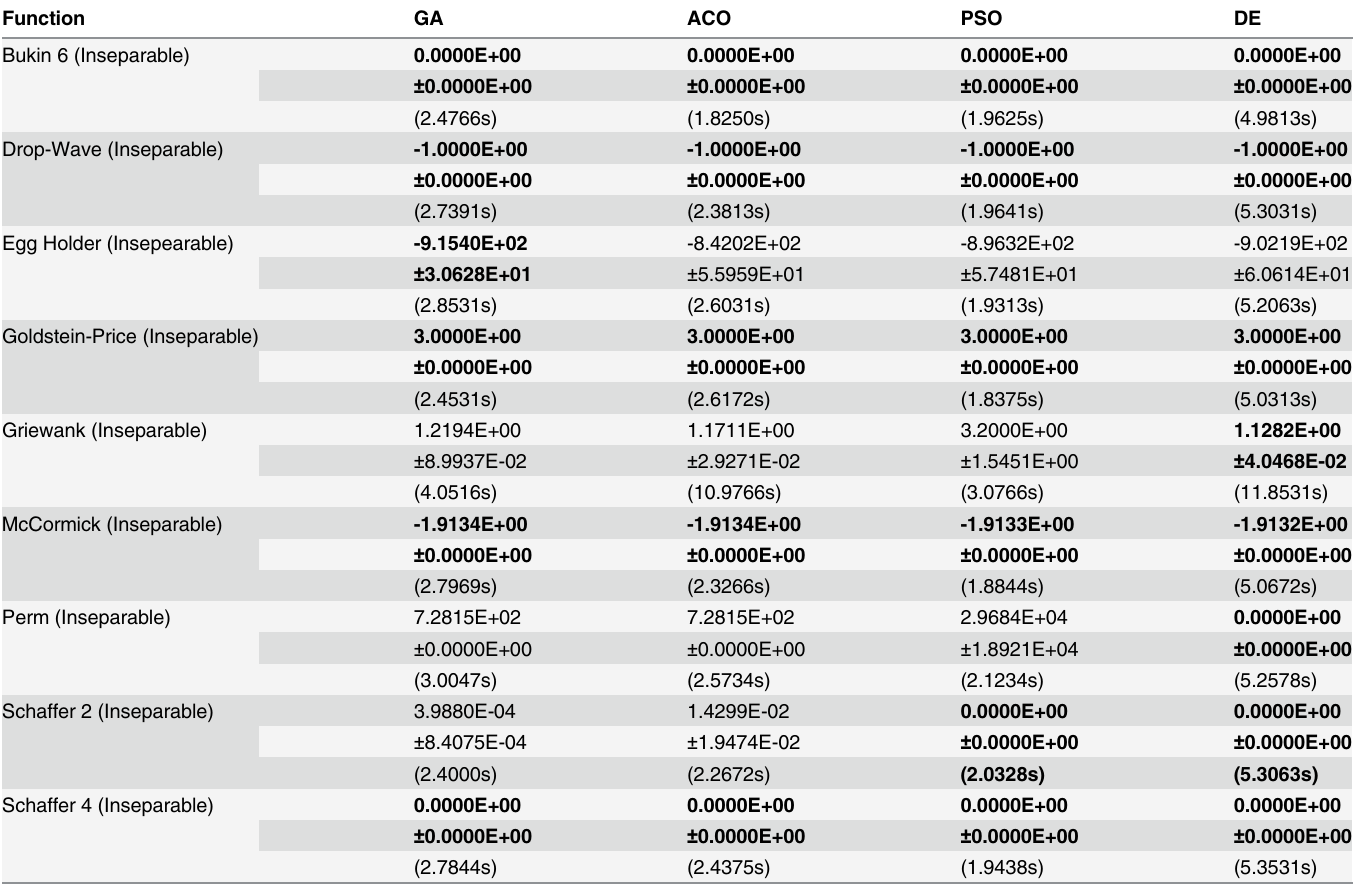
Table 7. Benchmark Functions Comparison of mean error (Mean ± SD) and time (Seconds) on Several Optimization Techniques. Function GA ACO PSO DE Bukin 6 (Inseparable)